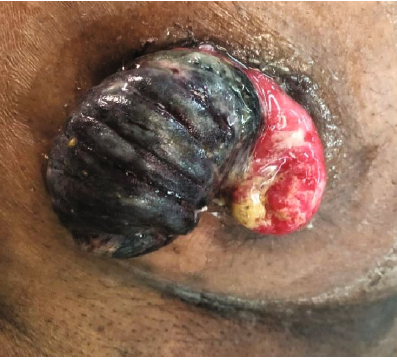
Figure 1: Photograph of distal loop prolapse of defunctioning loop ileostomy.